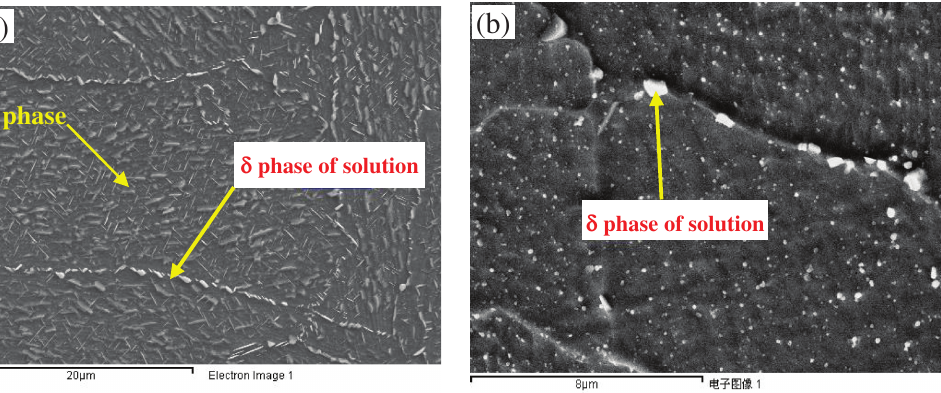
Figure 6: SEM morphology of typical precipitates under different solution temperature: (a) Local SEM morphology of B process and (b) Local SEM morphology of C